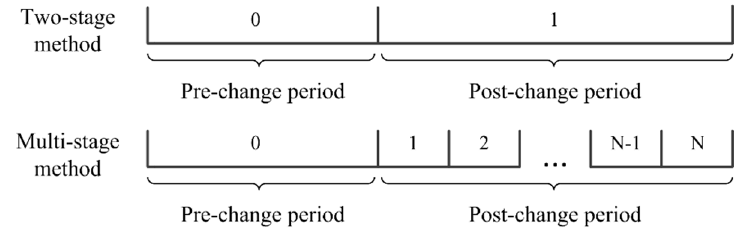
Figure 2. Divisions of study period by two-stage method and multi-stage method.